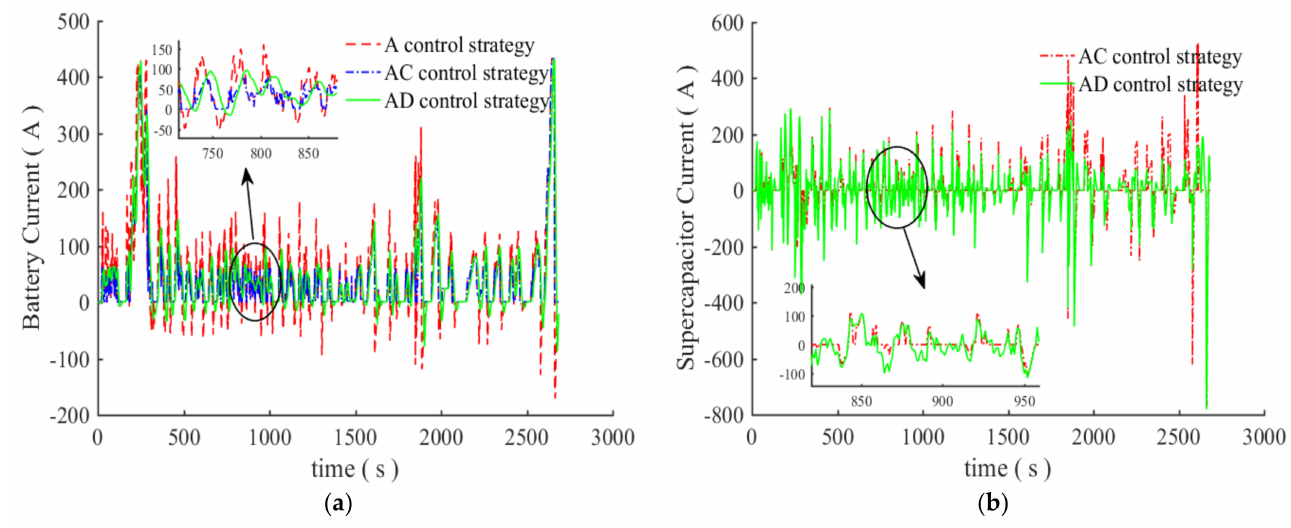
Figure 10. Current variation diagram of the battery and supercapacitor: ( a ) battery current; ( b ) super- capacitor